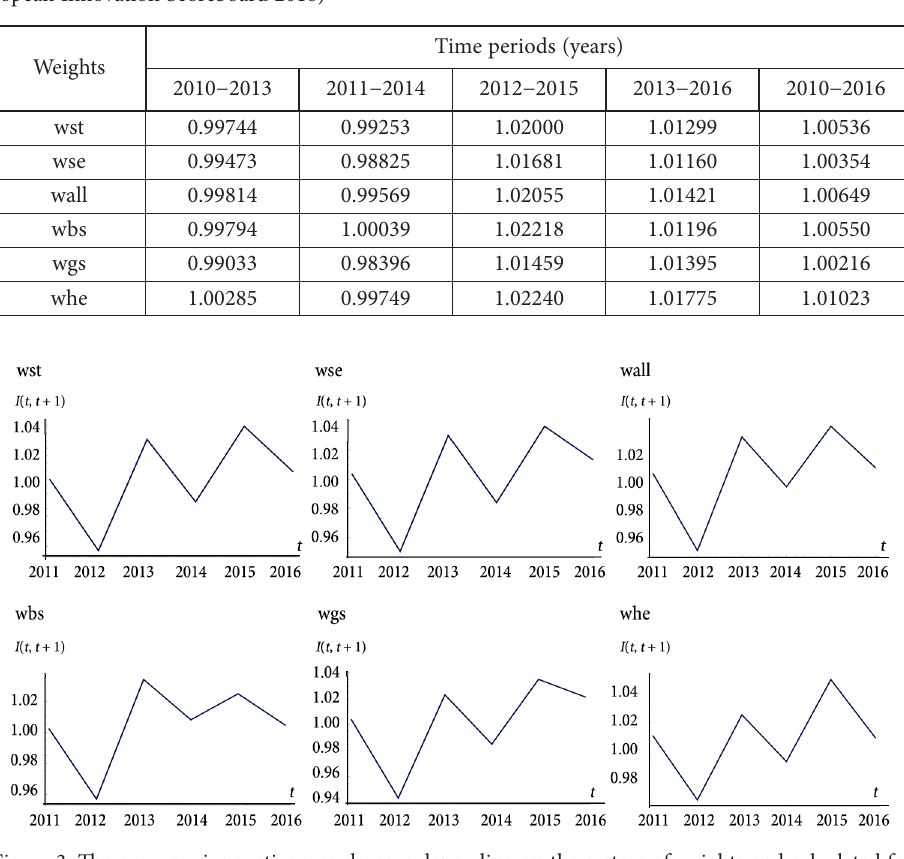
Table 6. The average innovativeness change ( , ) I s t calculated for the EU-13 (source: own elaboration based on the data of the European Statistical Office – Eurostat and European Commission, 2018. Eu-